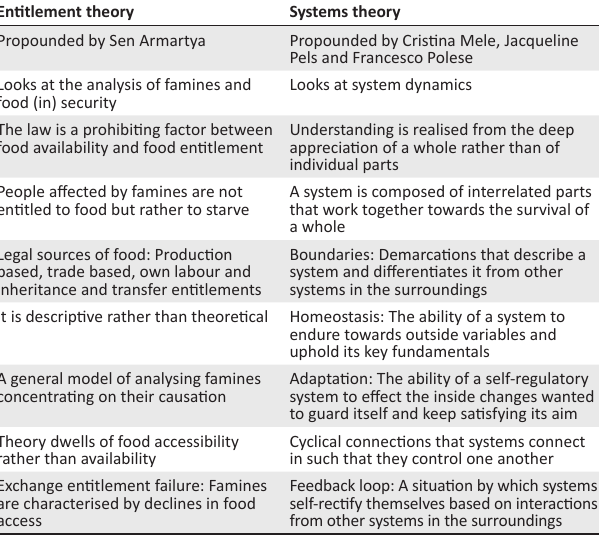
TABLE 1 : Major characteristics of the entitlement theory and systems